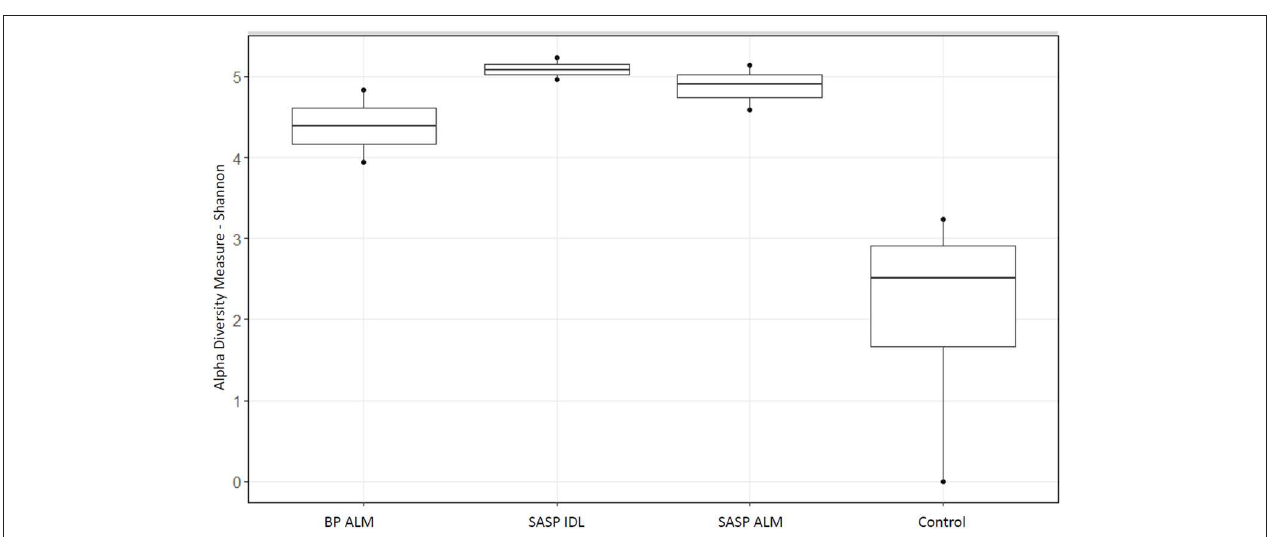
FIGURE 2 | Shannon diversity index of extraction controls vs. dust-impacted snow samples, with Berthoud Pass merged layer (BP ALM) showing less diversity than the Swamp Angel Study Plot individual dust event layer and merged layer (SASP IDL and ALM, respectively), vs. the control.